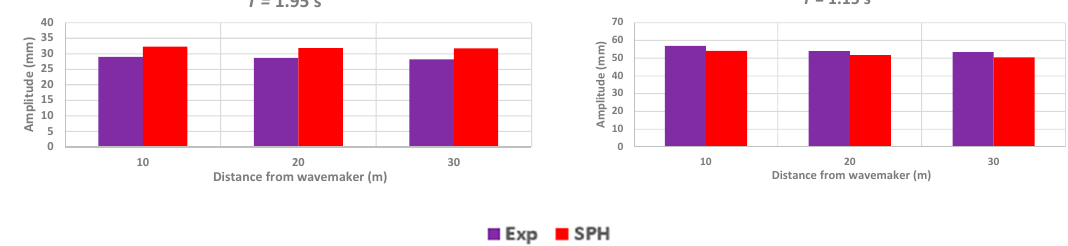
Figure 12. Comparison of wave amplitude at different positions for A = 33.0 mm and d = 0.75 m.